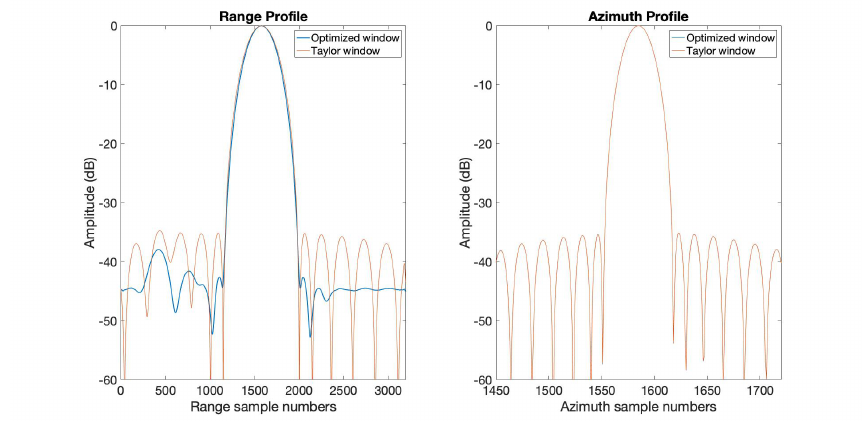
Figure 10. The range and azimuth profiles of the point targets in Figure